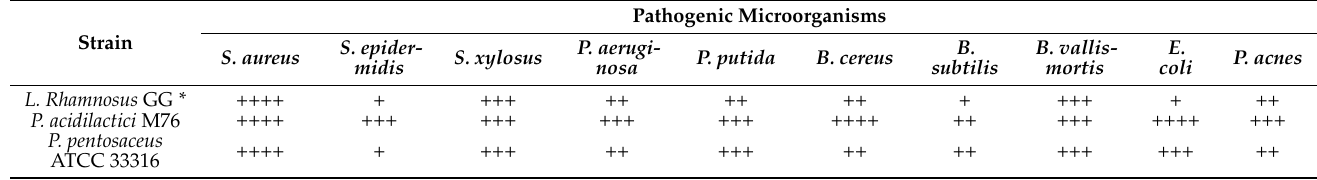
Table 2. Inhibitory activity of Pediococcus acidilactici M76 against pathogenic microorganisms.